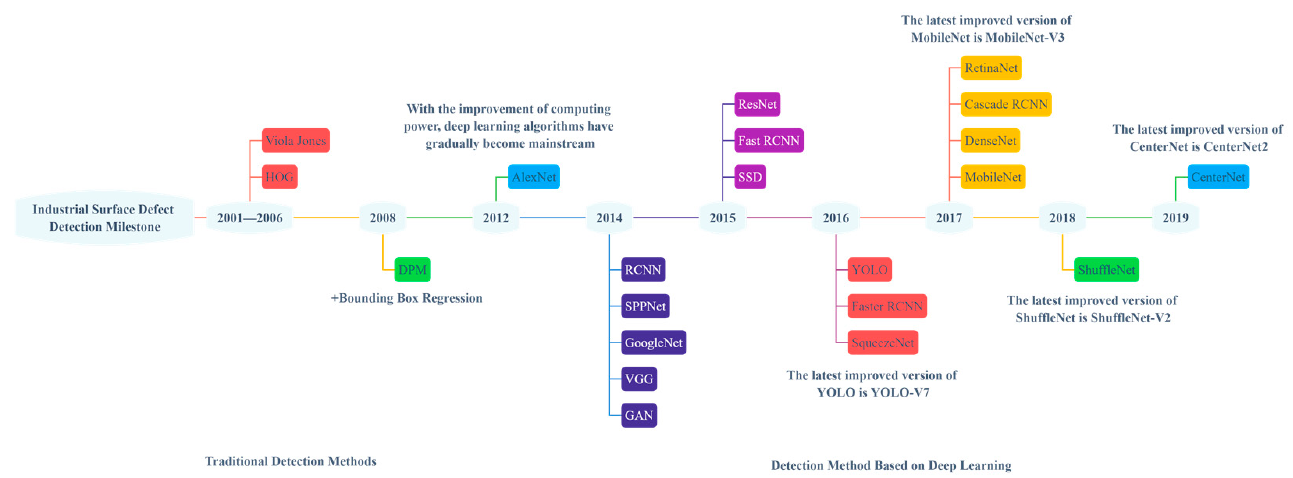
Figure 2. Development process of technologies related to industrial surface defect detection. Viola